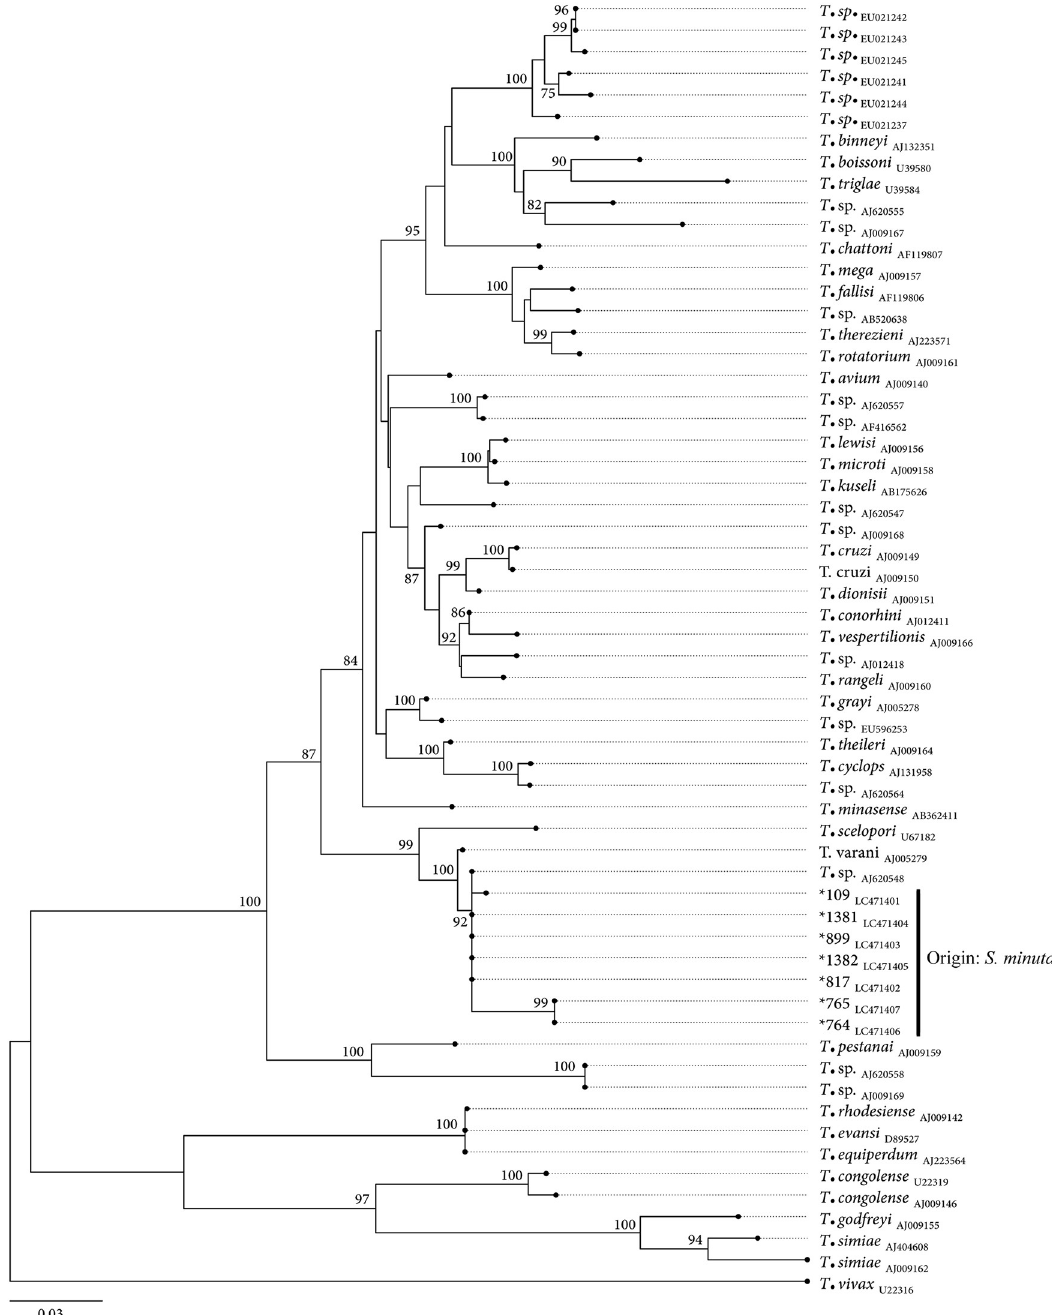
Fig 3. Maximum likelihood phylogenetic tree based on unambiguous multiple- Trypanosoma SSU-rDNA sequences alignment, using the GTR+G+I model of evolution. At specific branch nodes bootstrap values (from 1000 random replicates of the original dataset) � 75% are shown. The size bar indicates the number of nucleotide substitutions per site. The tree was rooted using as an outgroup a reference sequence of Trypanosoma brucei brucei (M94286). The sequences obtained in this study are identified with “ � ” and their respec- tive accession numbers underscored.